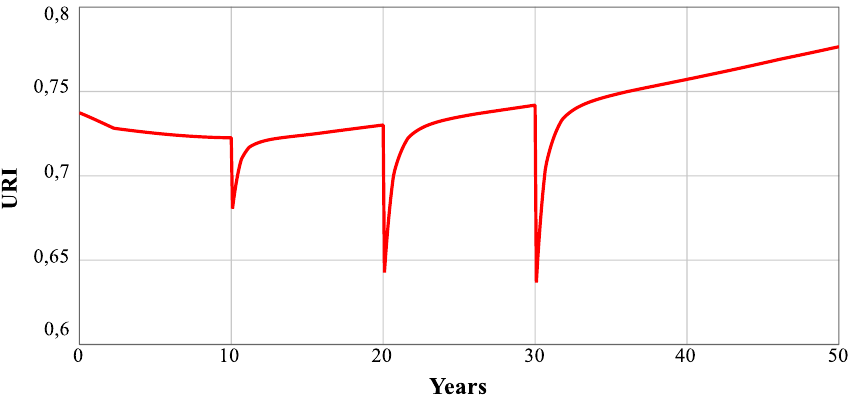
Fig. 6. Output of URI for Urban Resilience SD model simulation without occurrence of natural